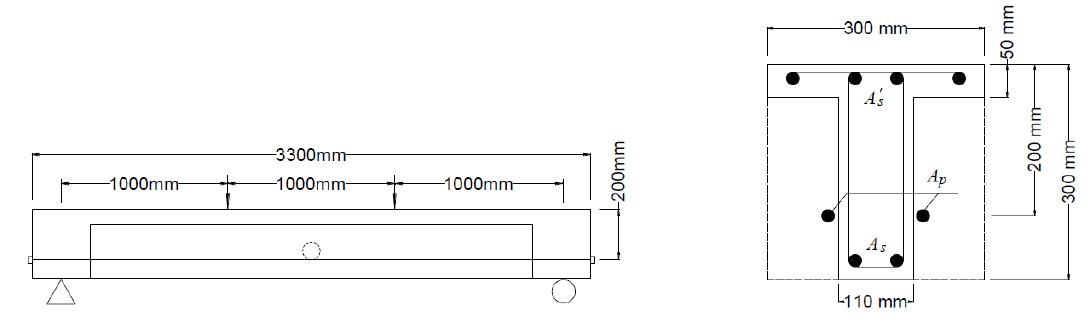
Figure 3. Prestressed concrete beam ( PCB) specimens with external CFRP tendons [20], A s ,